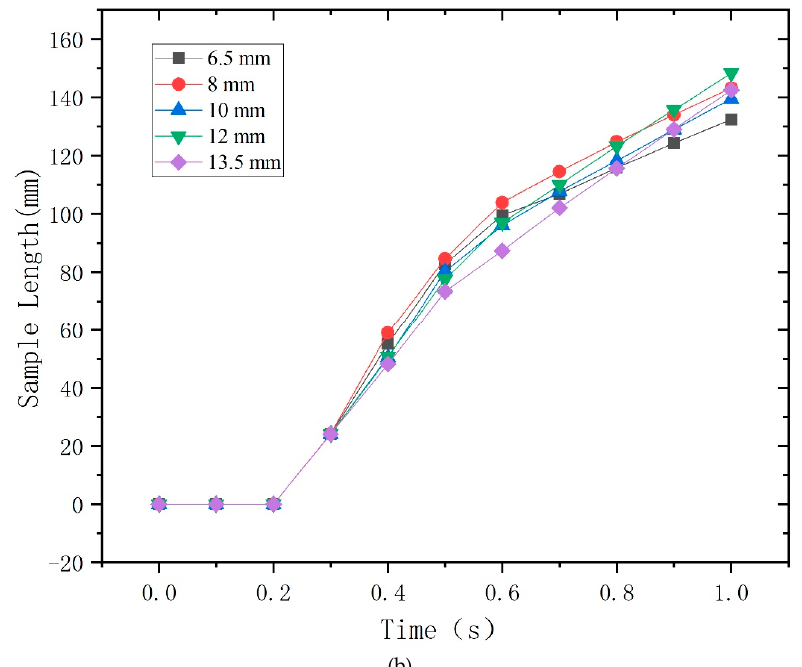
Figure 6. ( a ) Sampling length under different installation positions; ( b ) The sampling length under further adjustment. Table 3. Simulation results under different installation positions.